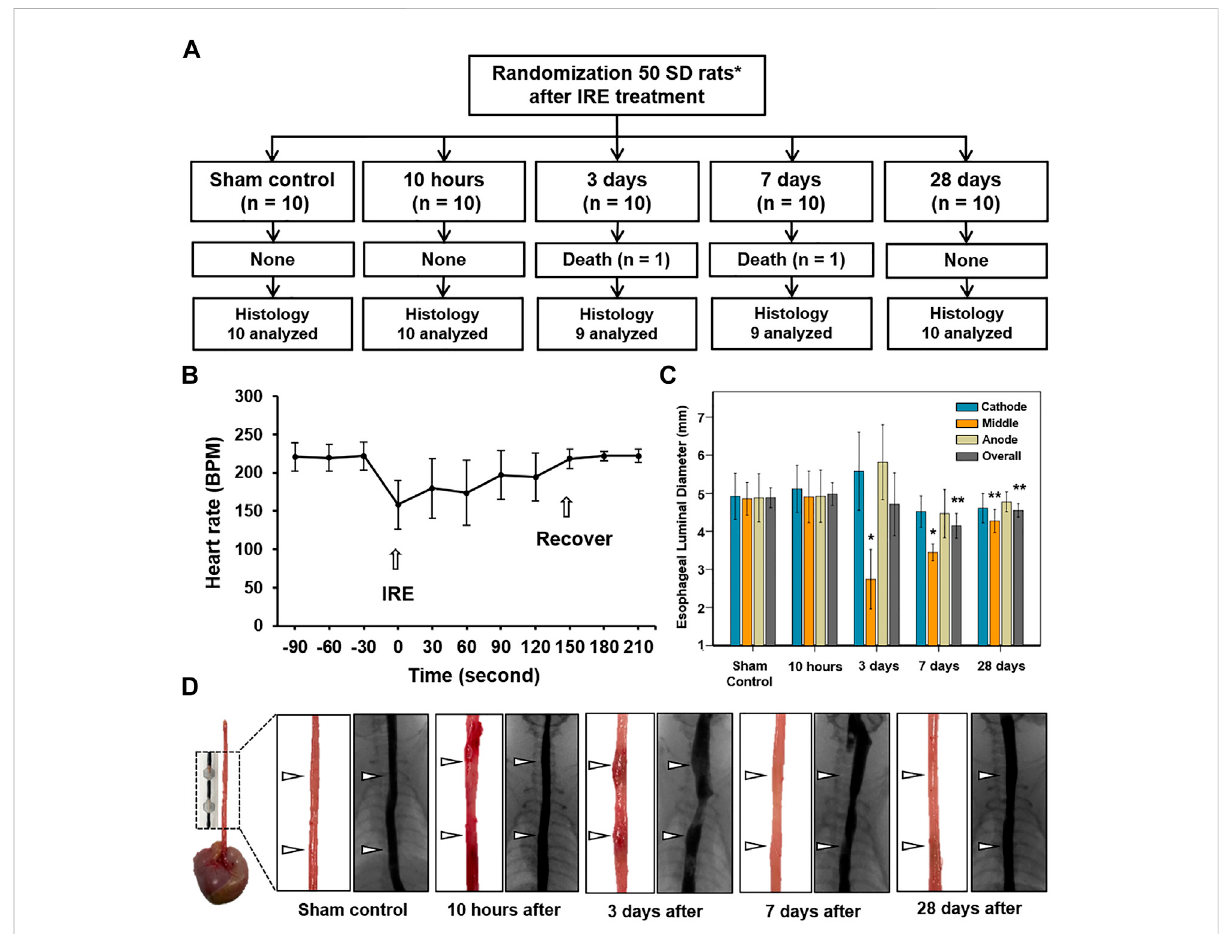
FIGURE 3 In vivo long-term experimental fi ndings by IRE treatment. (A) Experimental fl owchart showing the randomization process and study follow-up. (B) Graph shows that the electrocardiographic changes in the IRE-treated rats before and after the procedure. (C) Esophageal luminal diameter changes in study groups after IRE treatment. (D) Representative photographs of the gross and esophagographic images obtained from the sham control at 10 h, 3 days, 7 days, and 28 days after IRE treatment. Note: Data are presented as the mean ± SD. * p < 0.001 and ** p < 0.05. IRE, irreversible